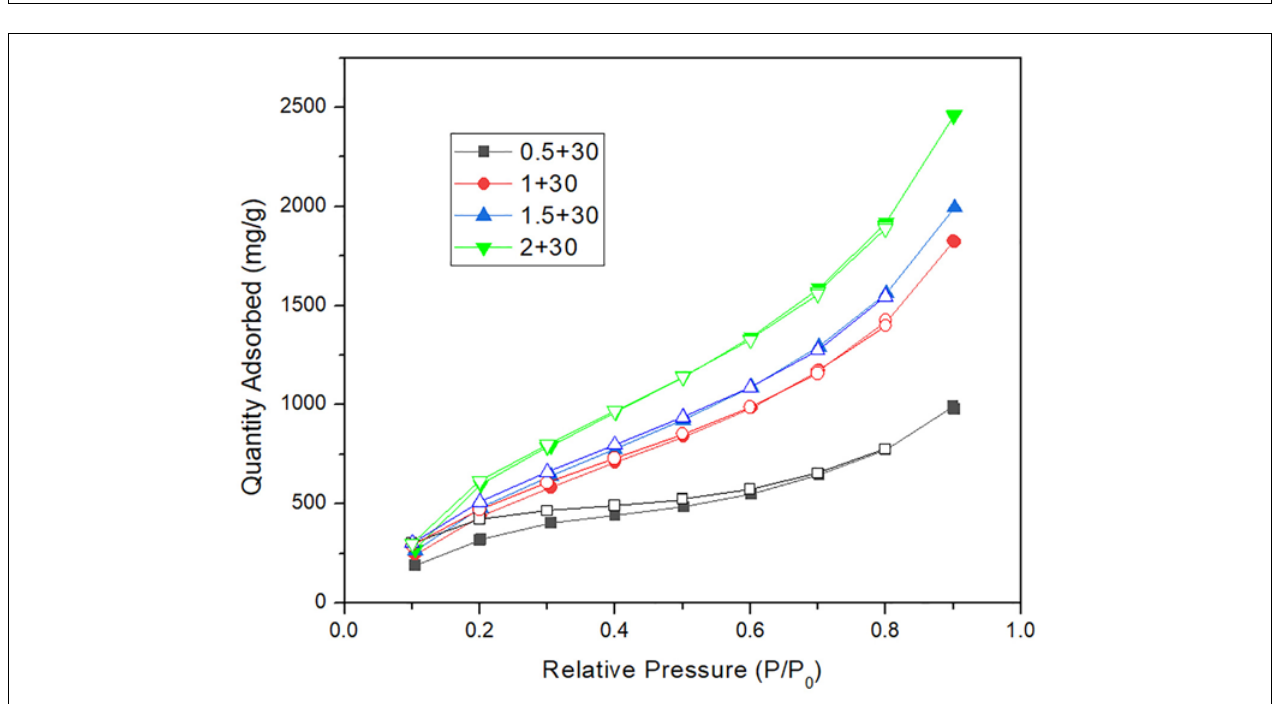
FIGURE 5 | Comparison of water adsorption isotherms of carbon nanotube mil-101 (Cr) composite with mil-101 (Cr) composite.